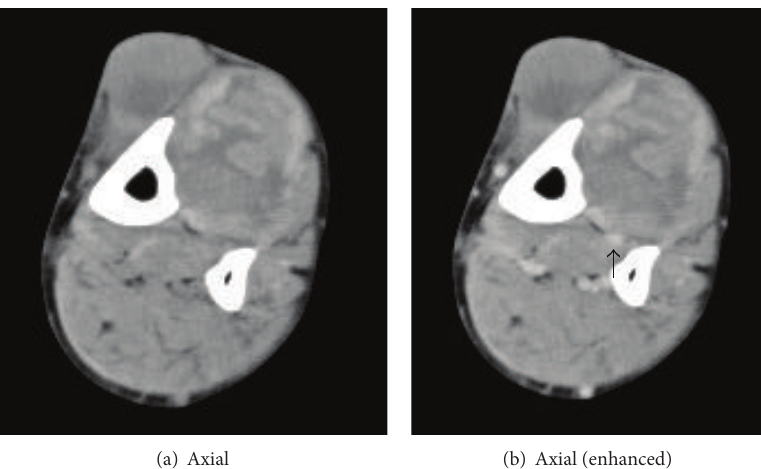
Figure 1: Computed tomography (CT) of left lower leg revealed a large mass (maximum diameter, 7.2 cm; length, 21.0 cm) with cystic lesions in the region of the TA and EHL muscles (a and b). The mass and cystic lesions were not contrasted but the anterior tibialis artery was clearly observed (arrow) by using enhanced CT